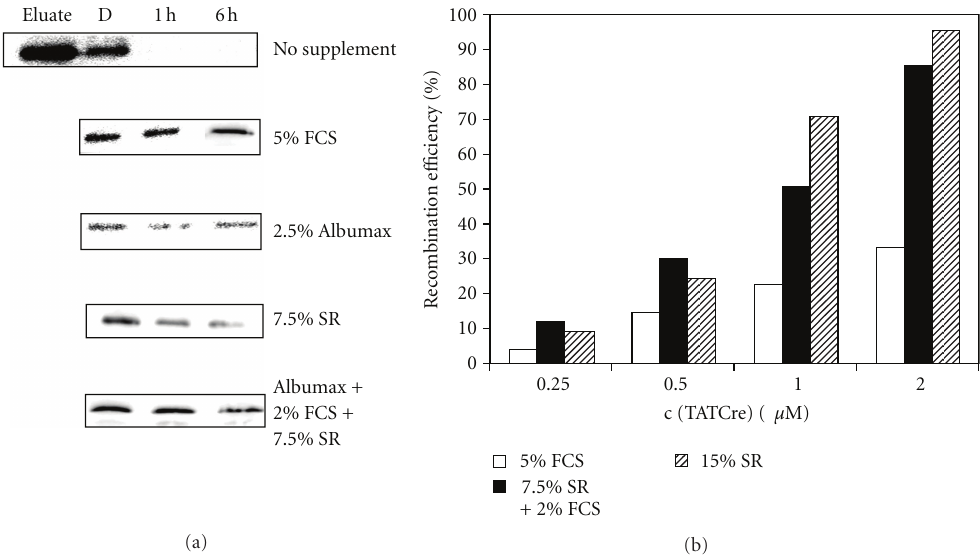
Figure 2: E ff ect of media supplements on the stability of cell-permeant Sox2-TAT fusion protein and e ffi ciency of protein delivery. (a) Ability of media supplements to stabilize Sox2-TAT. Fetal calf serum (FCS), Albumax, and serum replacement (SR) were added to the eluate fraction and subsequently dialyzed against DMEM-F12 media. Depicted are anti-Sox2-immunoblots of the dialysis fraction (D) and a stability test of samples being taken after 1 hour (1h) and 6 hours (6h), respectively. (b) Influence of FCS, SR, and a combination of both on the transduction e ffi ciency. Protein transduction e ffi ciencies were analyzed by quantifying the recombined cells after delivery of cell permeant Cre-protein (TAT-Cre) into the CV1-5B Cre reporter cell line. Cells were treated with di ff erent concentrations of TAT-Cre (0.25 μ M–2 μ M) in transduction media supplemented with either 15% serum replacement, 5% FCS, or mixture of 2% FCS and 7.5% SR. To determine the recombination activity, cells were fixed and stained for β -galactosidase activity after 48 hours. Cre protein transduction and quantification of recombination in Cre reporter cells was performed as described previously